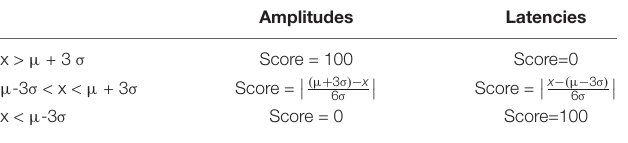
TABLE 1 | Brain vital sign standardized scoring